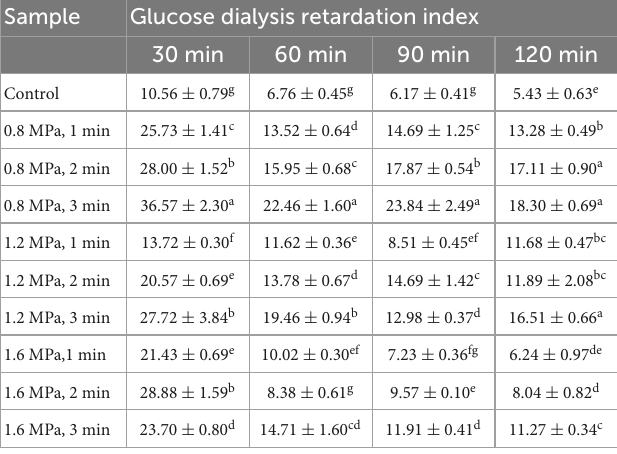
TABLE 2 Effect of steam explosion (SE) pretreatment on glucose dialysis retardation index (GDRI) of adlay bran soluble dietary fiber (SDF). Sample